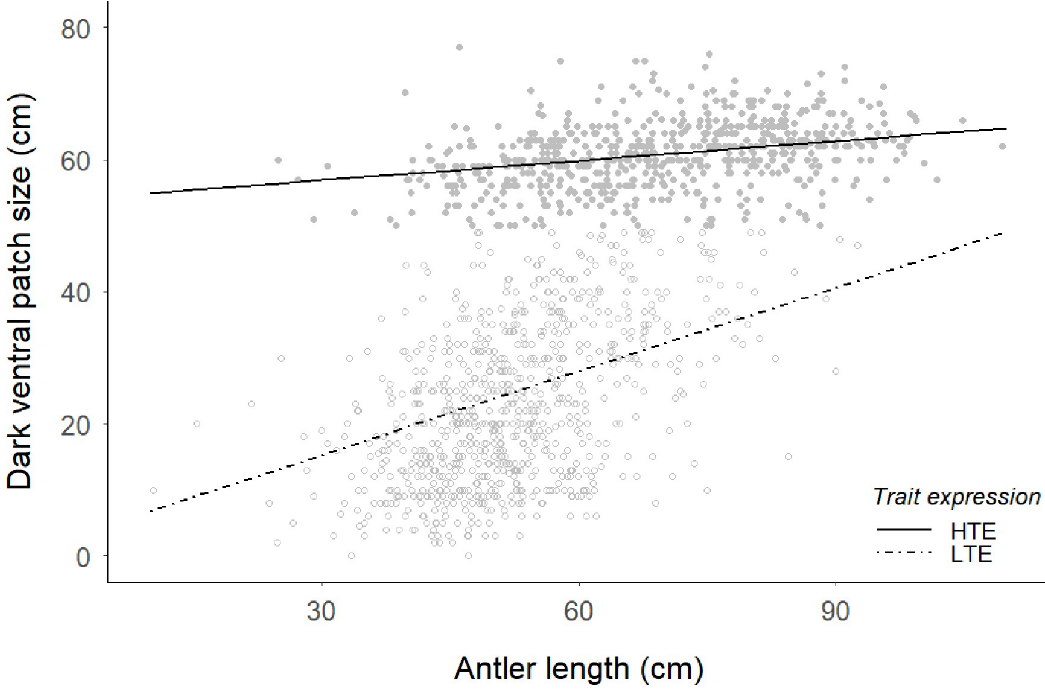
Fig 3. Predictions of the dark ventral patch size (cm) against antler length (cm) from the model on Table 1 for the two trait- expression groups of red deer males (HTE: solid line; LTE, dashed line). Points are raw, untransformed data for the dark ventral patch size (HTE: grey filled points; LTE, grey open points).